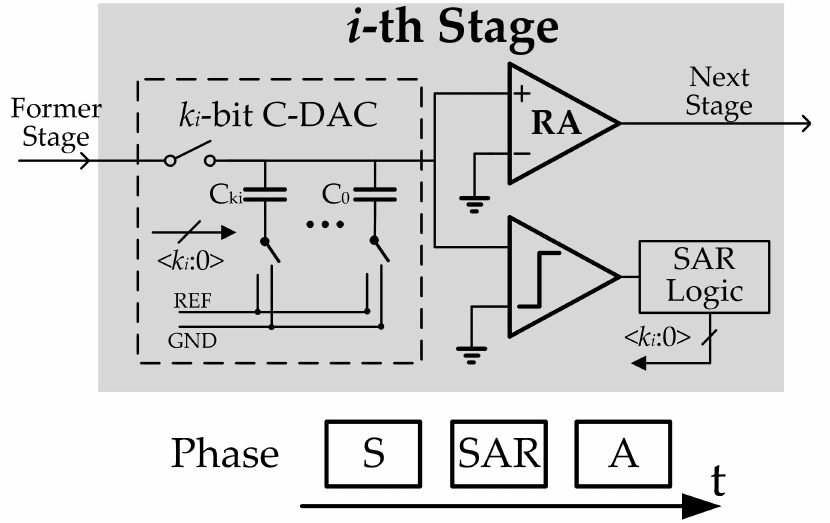
Figure 2. Block diagram of a pipelined-SAR ADC. The area marked with grey represents the critical blocks in the i -th stage. The detailed structure of the C-DAC, including capacitor array and sampling switch, is in the dashed box. A simplified timing diagram is drawn